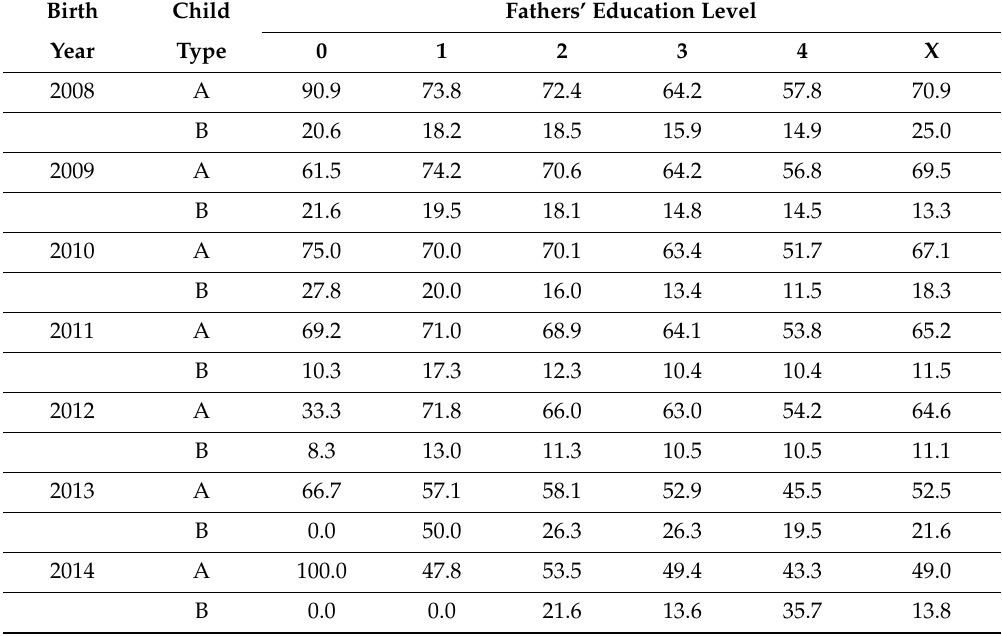
Figure 5. Predicted return rates of Type B children by birth cohort. As shown by the noncumulative return rates, it is predicted that only 77.8% of Type A children born in 2004 will return to Hong Kong by age 21 (i.e., by 2025). The corresponding proportion for Type B children is 30.7%, which is similar to the official C&SD estimation. However, the predicted return rate generally decreases with years of increasing birth cohort. For example, for the birth cohort 2012, the predicted return rates drop to 62.5% for Type A and 20.5% for Type B children by the age of 21 (i.e., year 2033). Amongst the 65,753 Type A and 195,042 Type B children born between the birth cohorts 2004 and 2014, under assumptions used by C&SD, there will be around 124,000 children returning to Hong Kong by age 21. Under the predicted return rates in this study, the corresponding number is only about 89,000. The estimated difference of 35,000 fewer children and young people returning is very substantial. 4. Discussion We examined the historical Hong Kong return rates of Type A and Type B children and made predictions for future rates, which are crucial for social service provision. The number of returnees and also their return times are important considerations. The proposed Markov chain model has